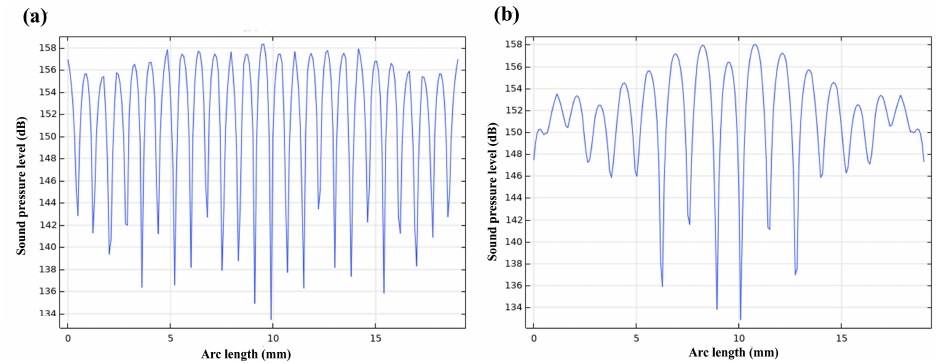
Figure 6. Comparison of pentagonal sound pressure level lines in the x direction in ( a ) the IEM mode